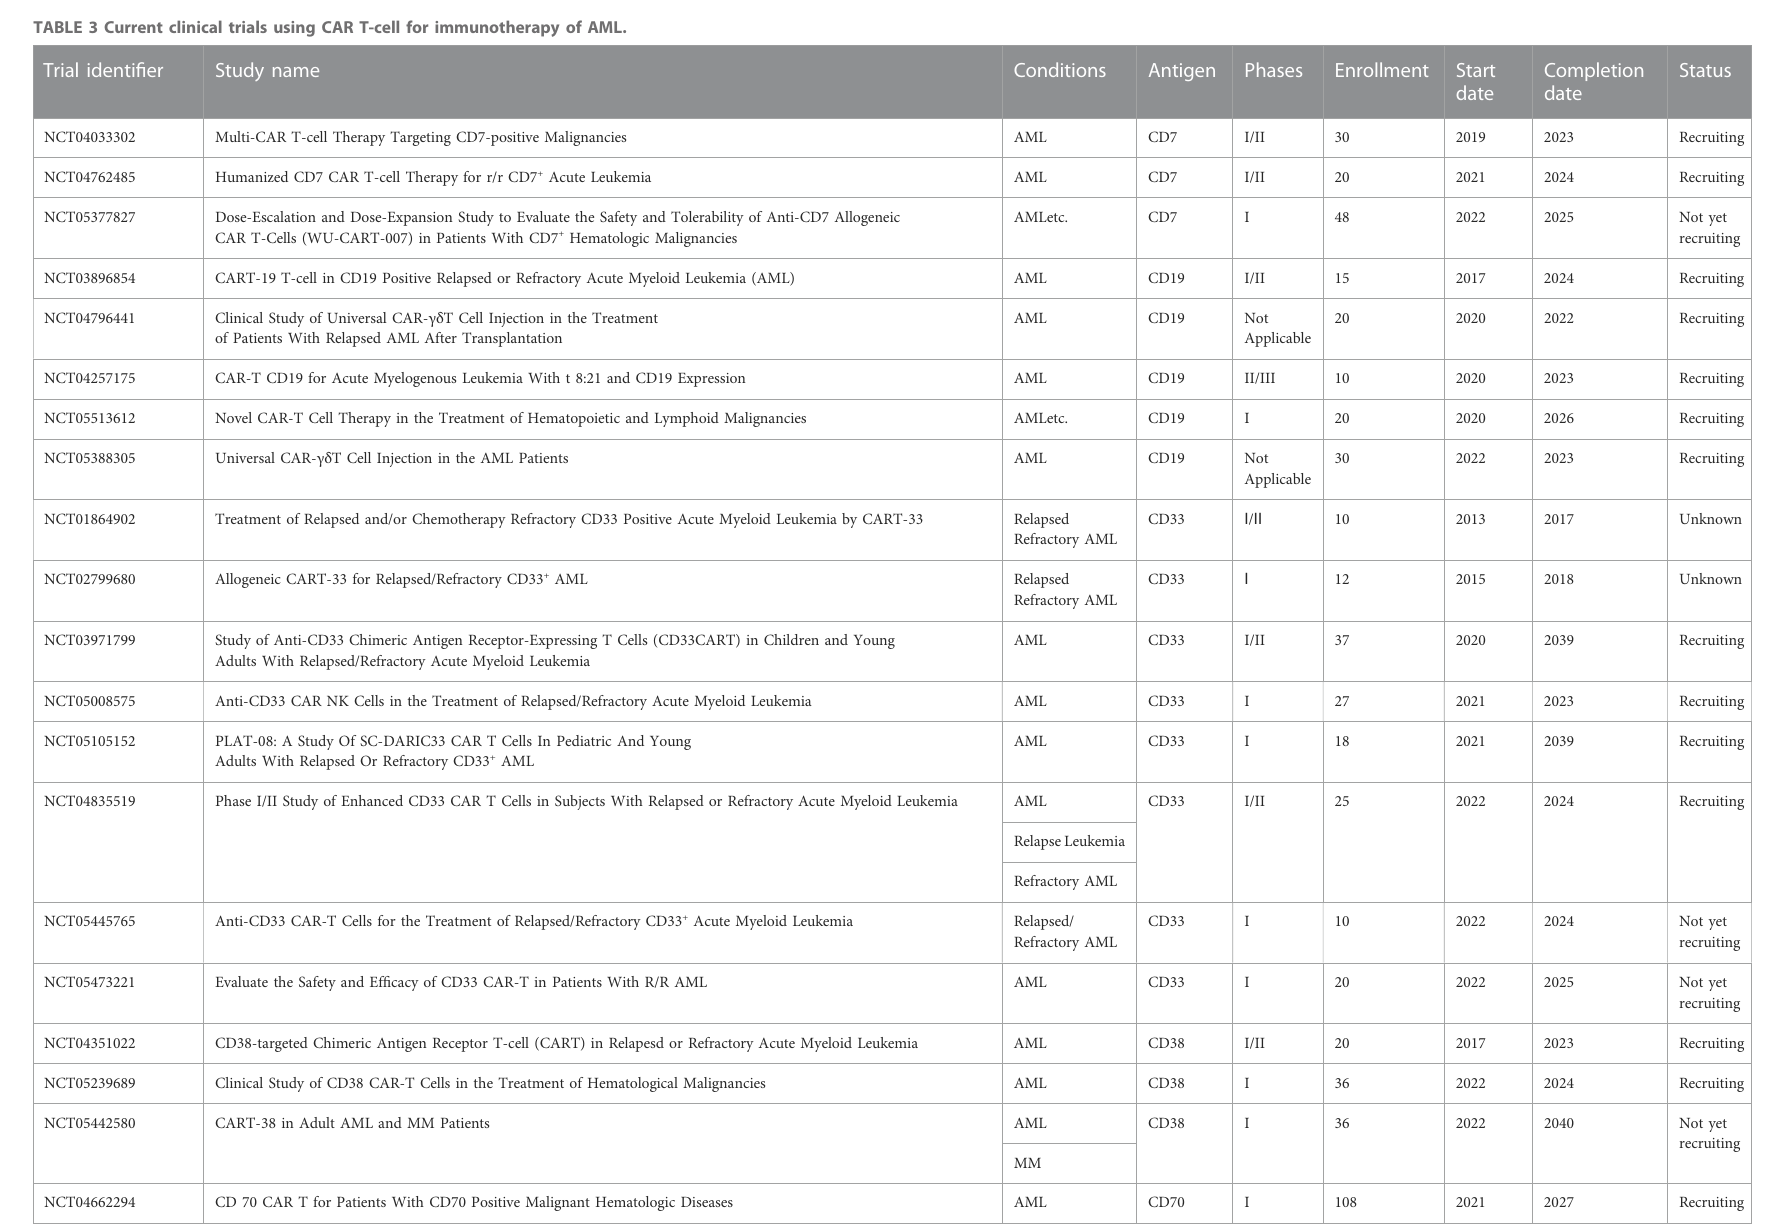
TABLE 3 Current clinical trials using CAR T-cell for immunotherapy of